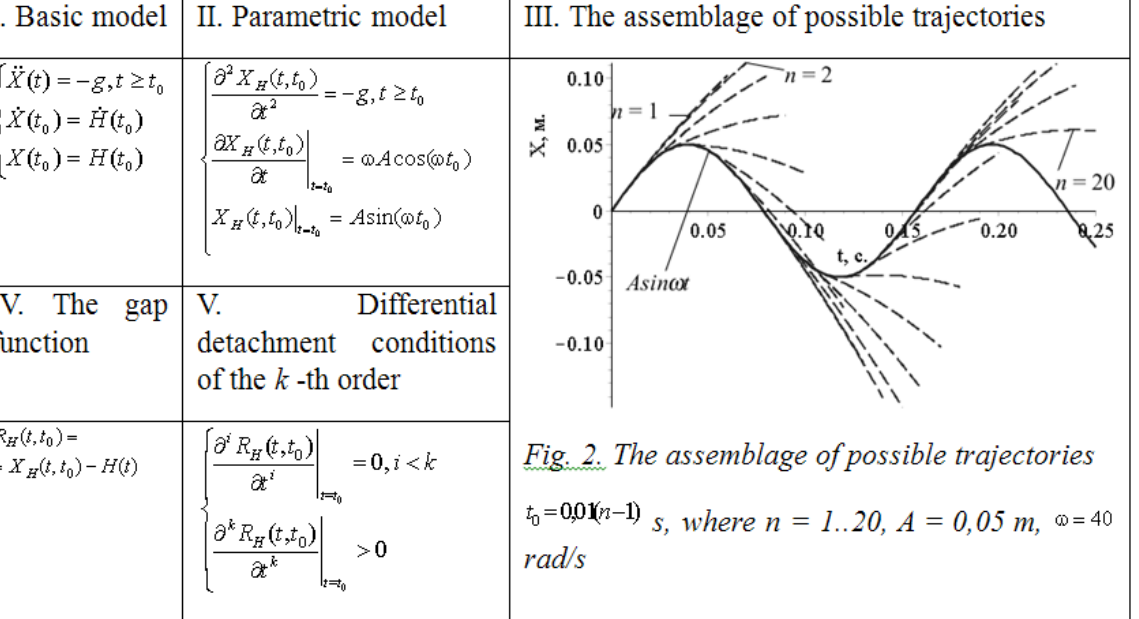
Elements of the analytical